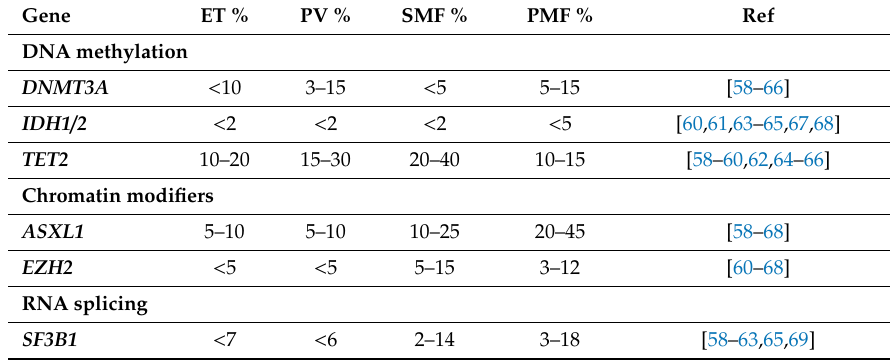
Table 1. The most common additional gene mutations in MPNs elaborated by NGS